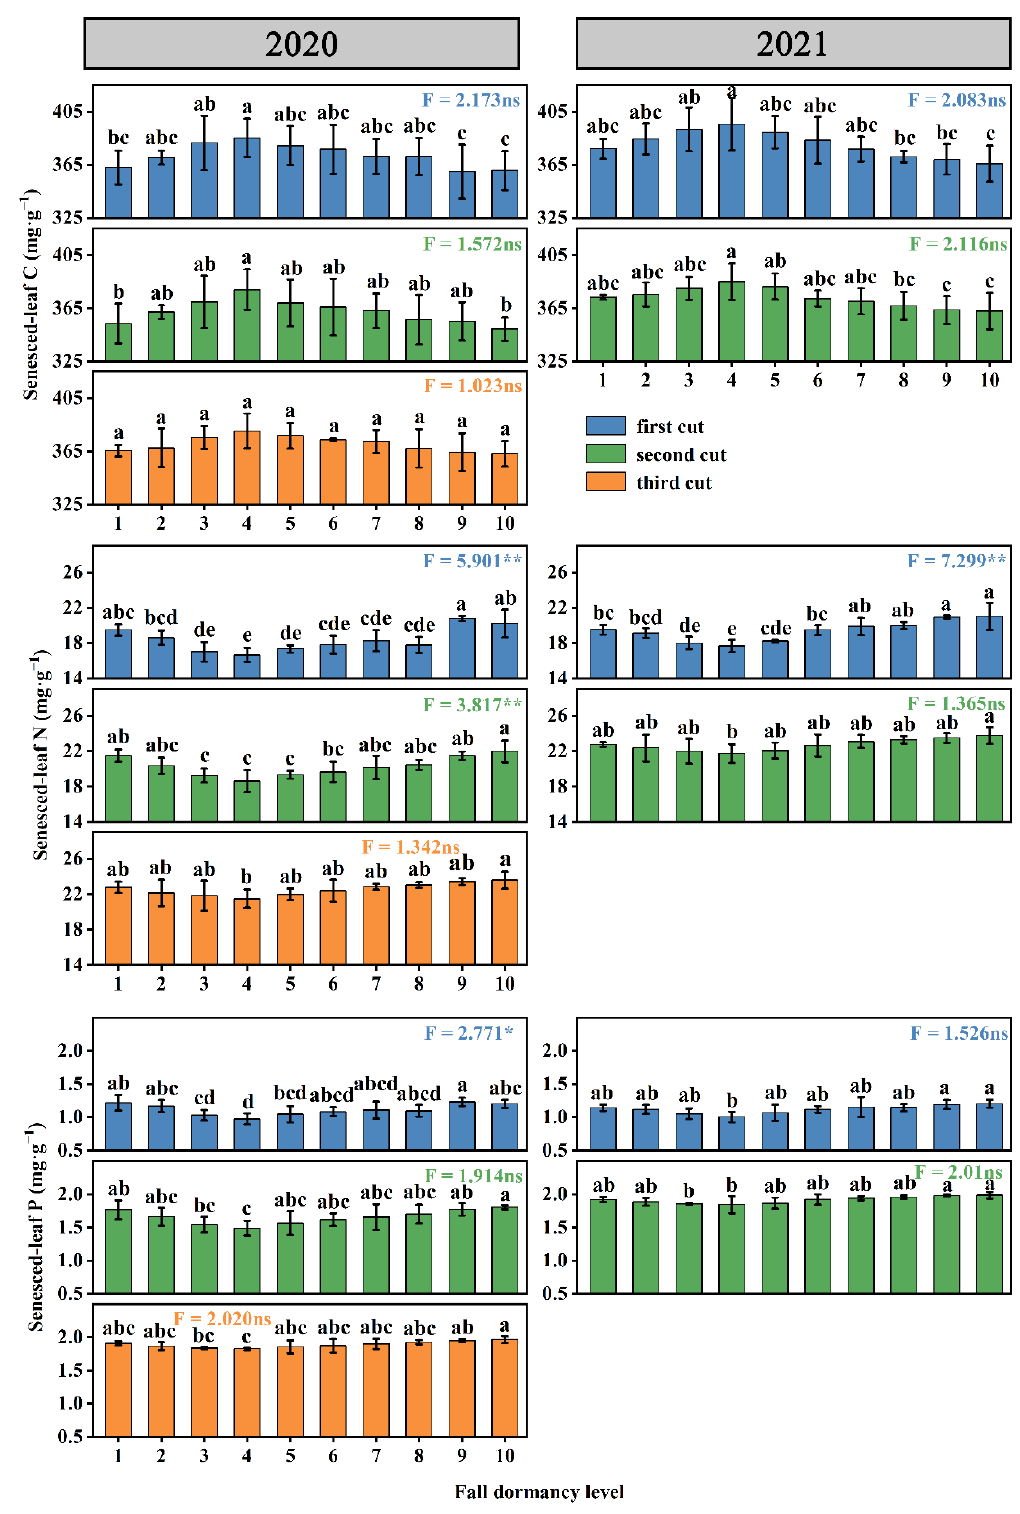
Figure 5. Stoichiometric characteristics of senescent alfalfa leaves with different fall-dormancy levels. Different small letters indicate significant differences between different fall dormancy levels ( p < 0.05). ns indicates no significant difference between different fall dormancy levels ( p > 0.05), * indicates significant difference between different fall dormancy levels ( p < 0.05) and ** indicates extremely significant difference between different fall dormancy levels ( p < 0.01).